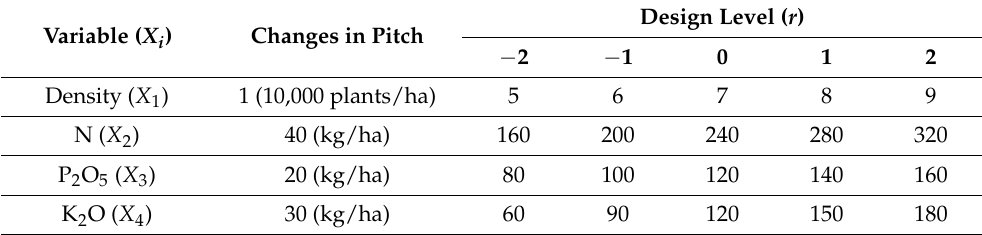
Table 1. Decisive variety x and linear coded